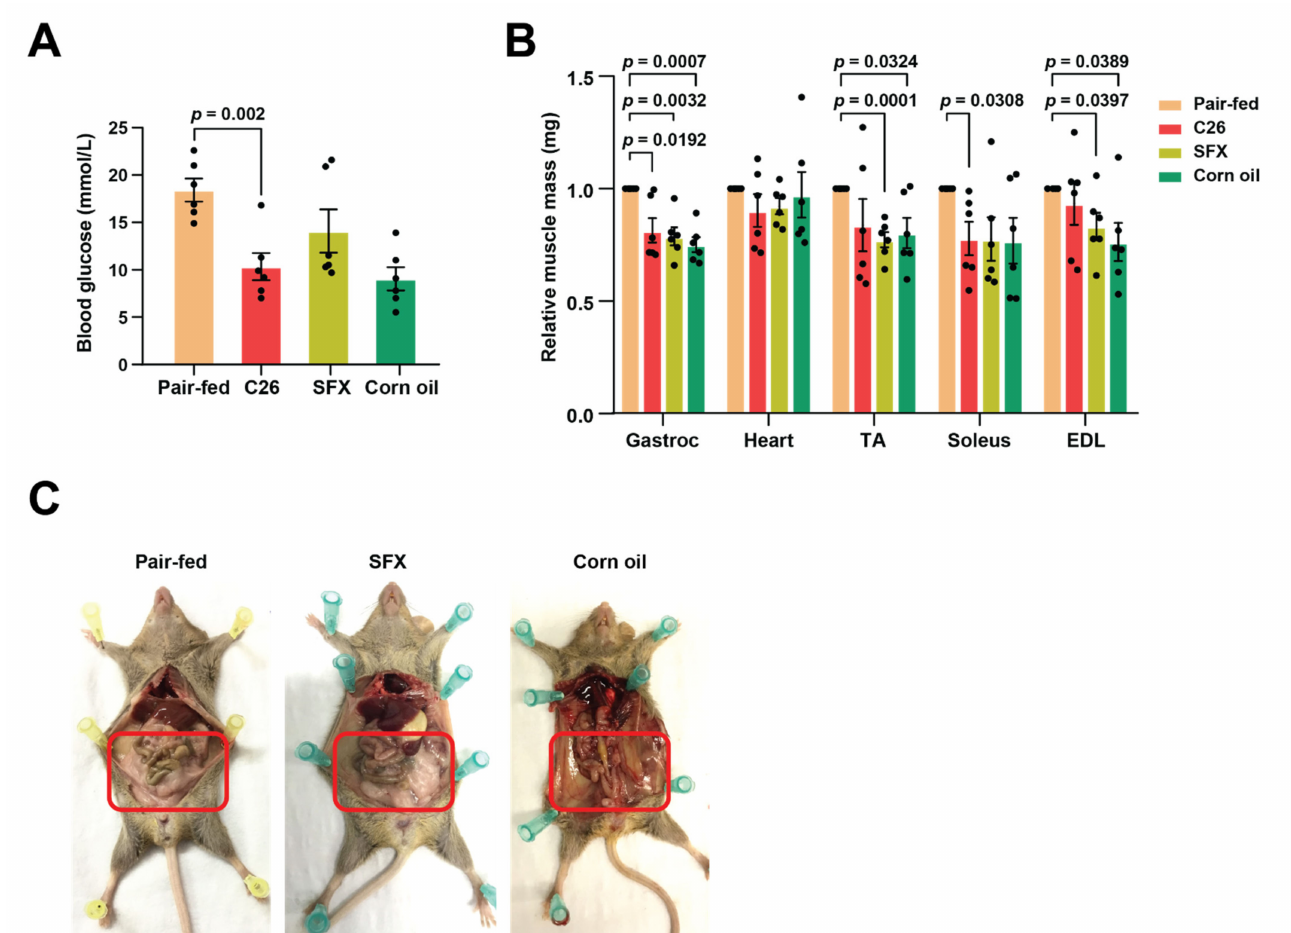
Figure 2. SFX rescues lipolytic weight loss in C26 tumour-bearing mice. ( A ) Dot plot representing the terminal blood glucose levels analysed using a glucometer. ( B ) Dot plot showing relative muscle mass of TA: Tibialis anterior, EDL: Extensor digito- rum longus, Gastroc: Gastrocnemius, soleus, and heart, excised and weighed upon scientific endpoint. ( C ) Representative images displaying fat deposits that were retained with SFX treatment when compared to the vehicle (corn oil) treatment. Highlighted area indicating the fat depot in pair-fed and SFX-treated mice. All data are representing mean ± SEM, unpaired two-tailed Student’s t -test ( n = 6 mice per